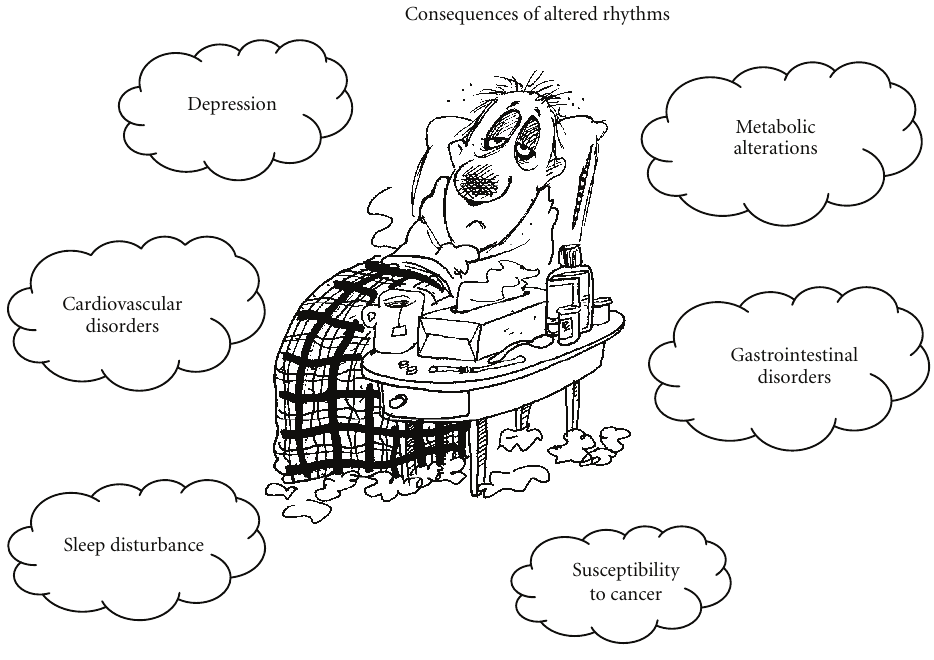
Figure 3: Schematic representation of health problems associated with internal desynchronization. The figure shows health problems that result from physiological changes in biological